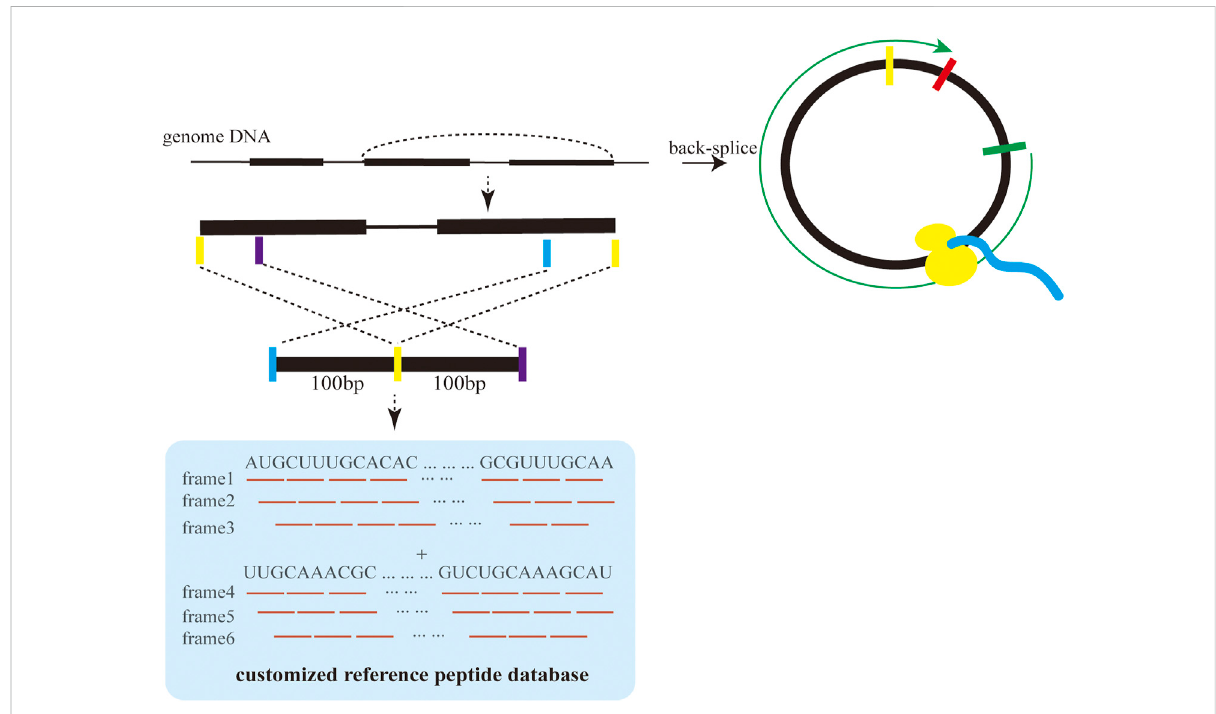
Construction of the reference peptide database based on circRNA